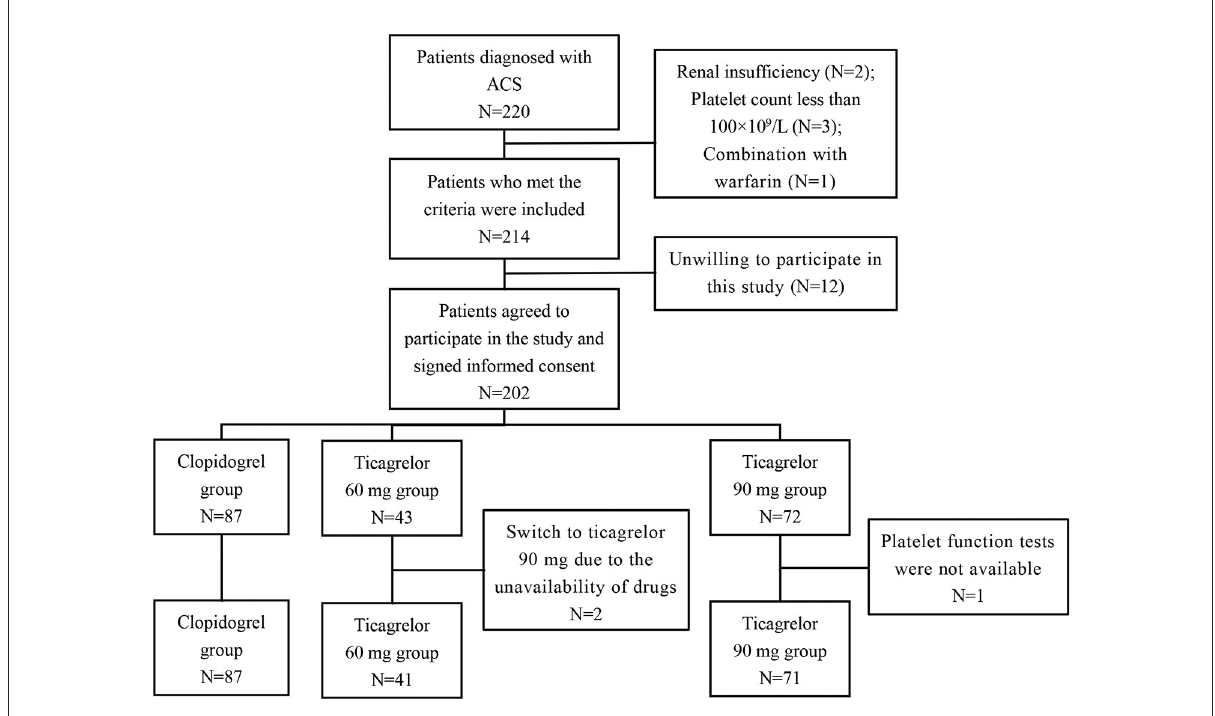
FIGURE1 Flowchart of cohort selection. ACS, acute coronary syndrome.